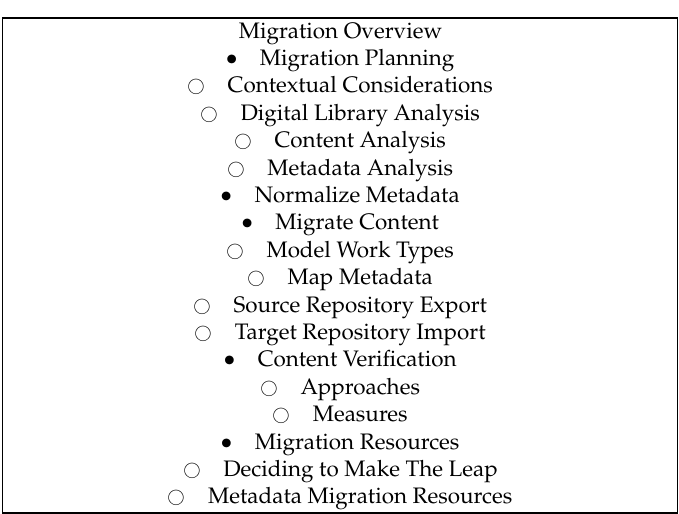
Table 1. Migration webpage